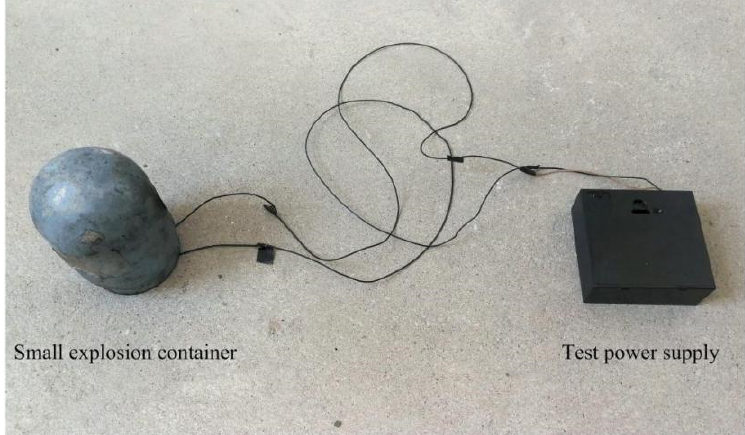
Figure 32. Explosion test device. Table 7. Dimensions before and after the tests (mm).